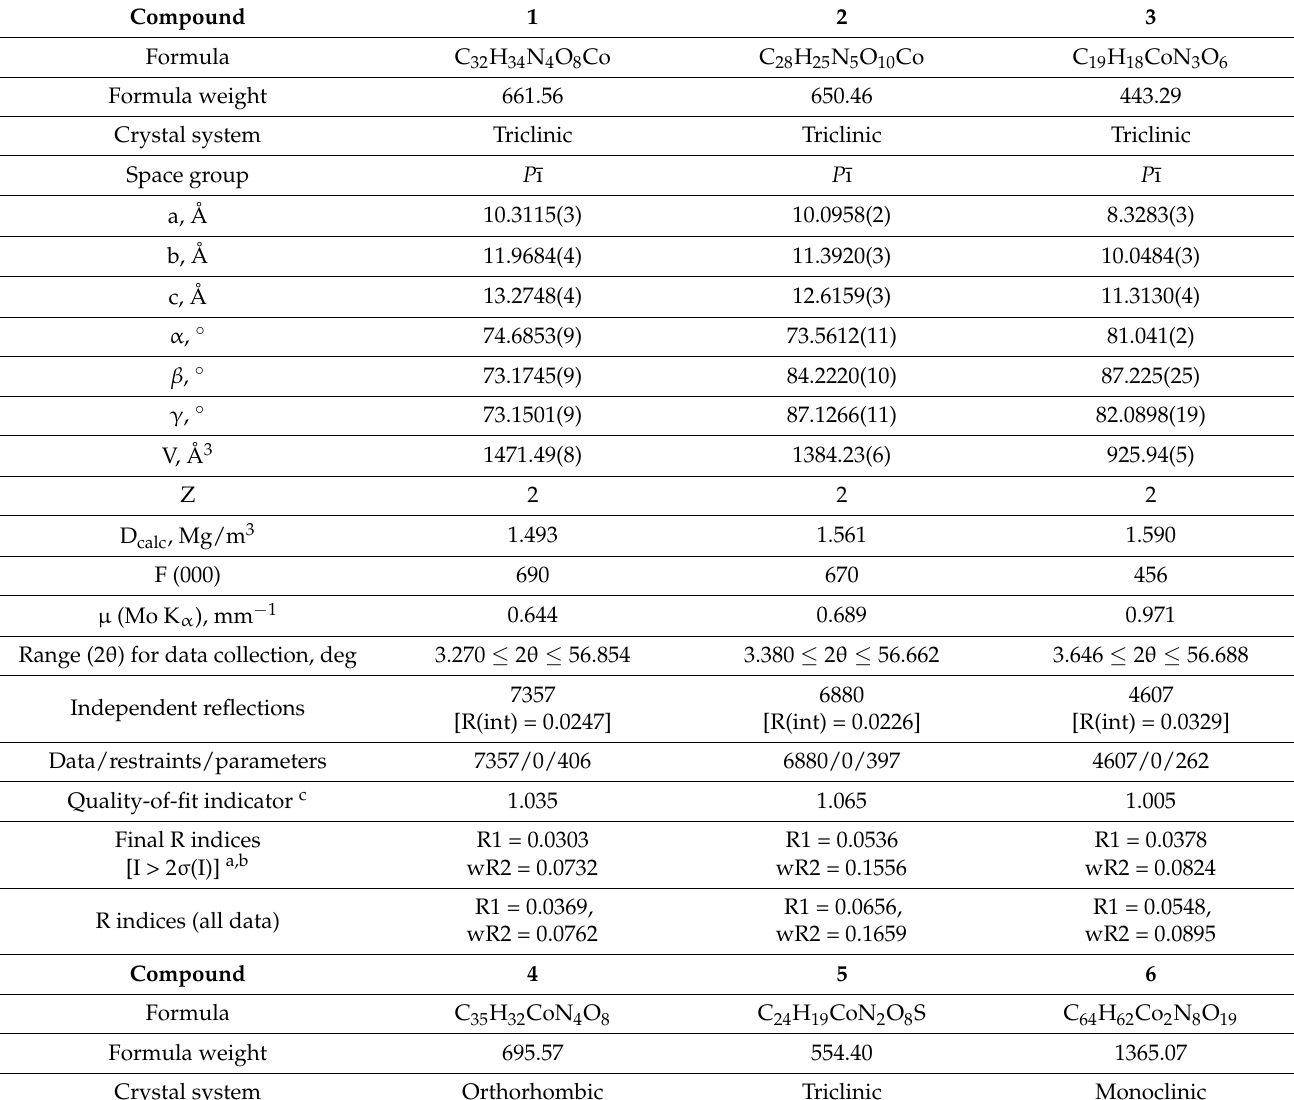
Table 2. Crystallographic data for 1 – 8